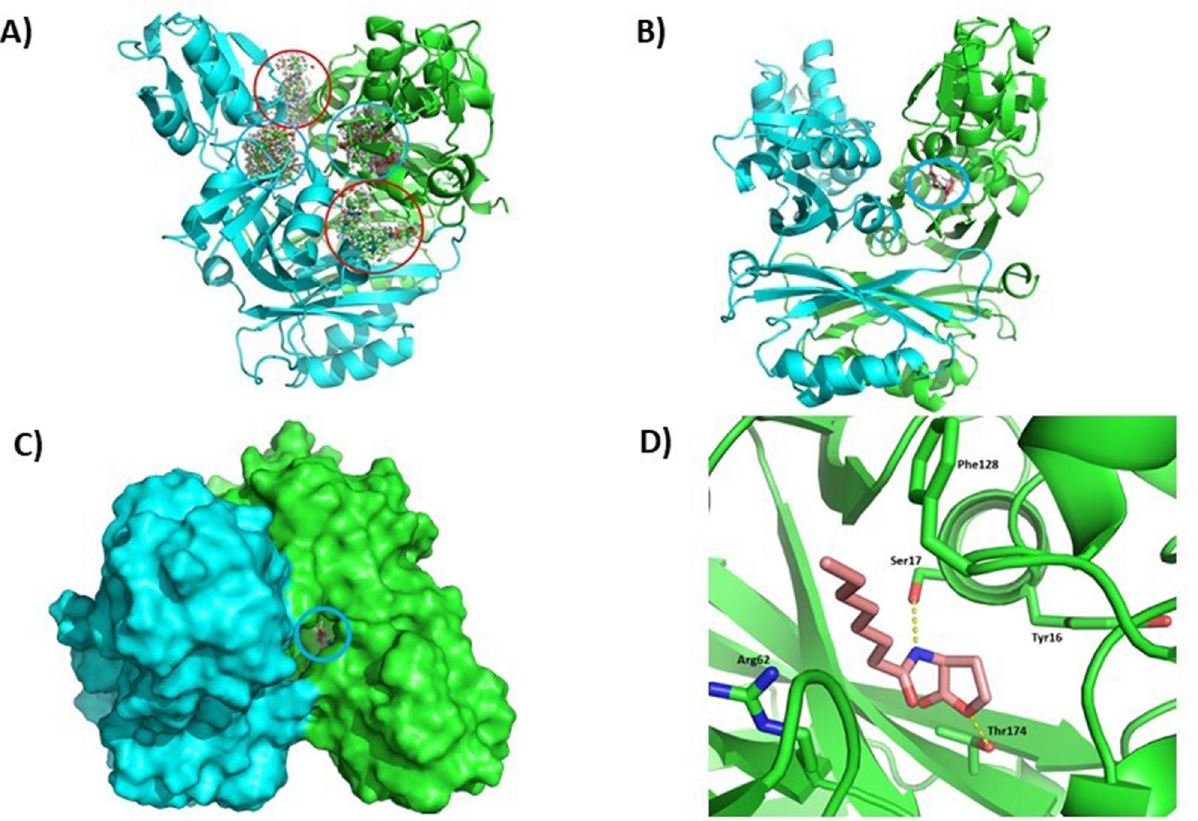
Figure 9. Identification of a putative active site of GqqA by docking studies with N-octanoyl-L-homoserine lactone. ( A ) SwissDock revealed clusters of two possible binding sites for each monomer (red circles or blue circles). The putative active site is located in the cleft between the subdomains of the catalytic PBP domain (blue circles). Another binding site is proposed on the solvent exposed surface in the neighbourhood of the active site (red circles). ( B – D ) Example of a possible ligand docking (blue circles in B, C ); Thr174 is in our model located at the bottom of the cleft near the protein interface. The modelled ligand (N-octanoyl-L-homoserine lactone) is most likely positioned between Ser17 and Thr174 and as proposed in ( D ). Thr174 as well as Ser17 are able to build hydrogen bonds to the ligand indicated with dots. Tyr16, Arg62 and Phe128 interact via van-der-Waals